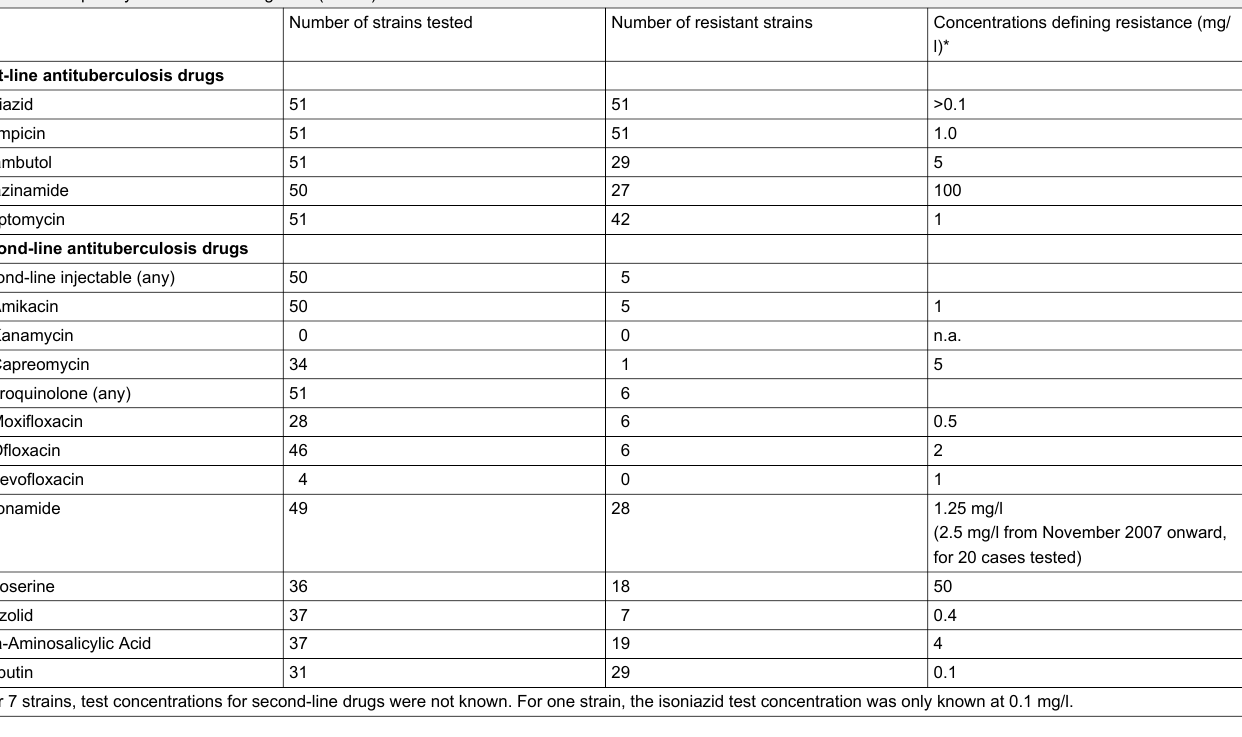
Table 3: Treatment outcomes at 24 months after start of MDR treatment (or any definite endpoint reached before).